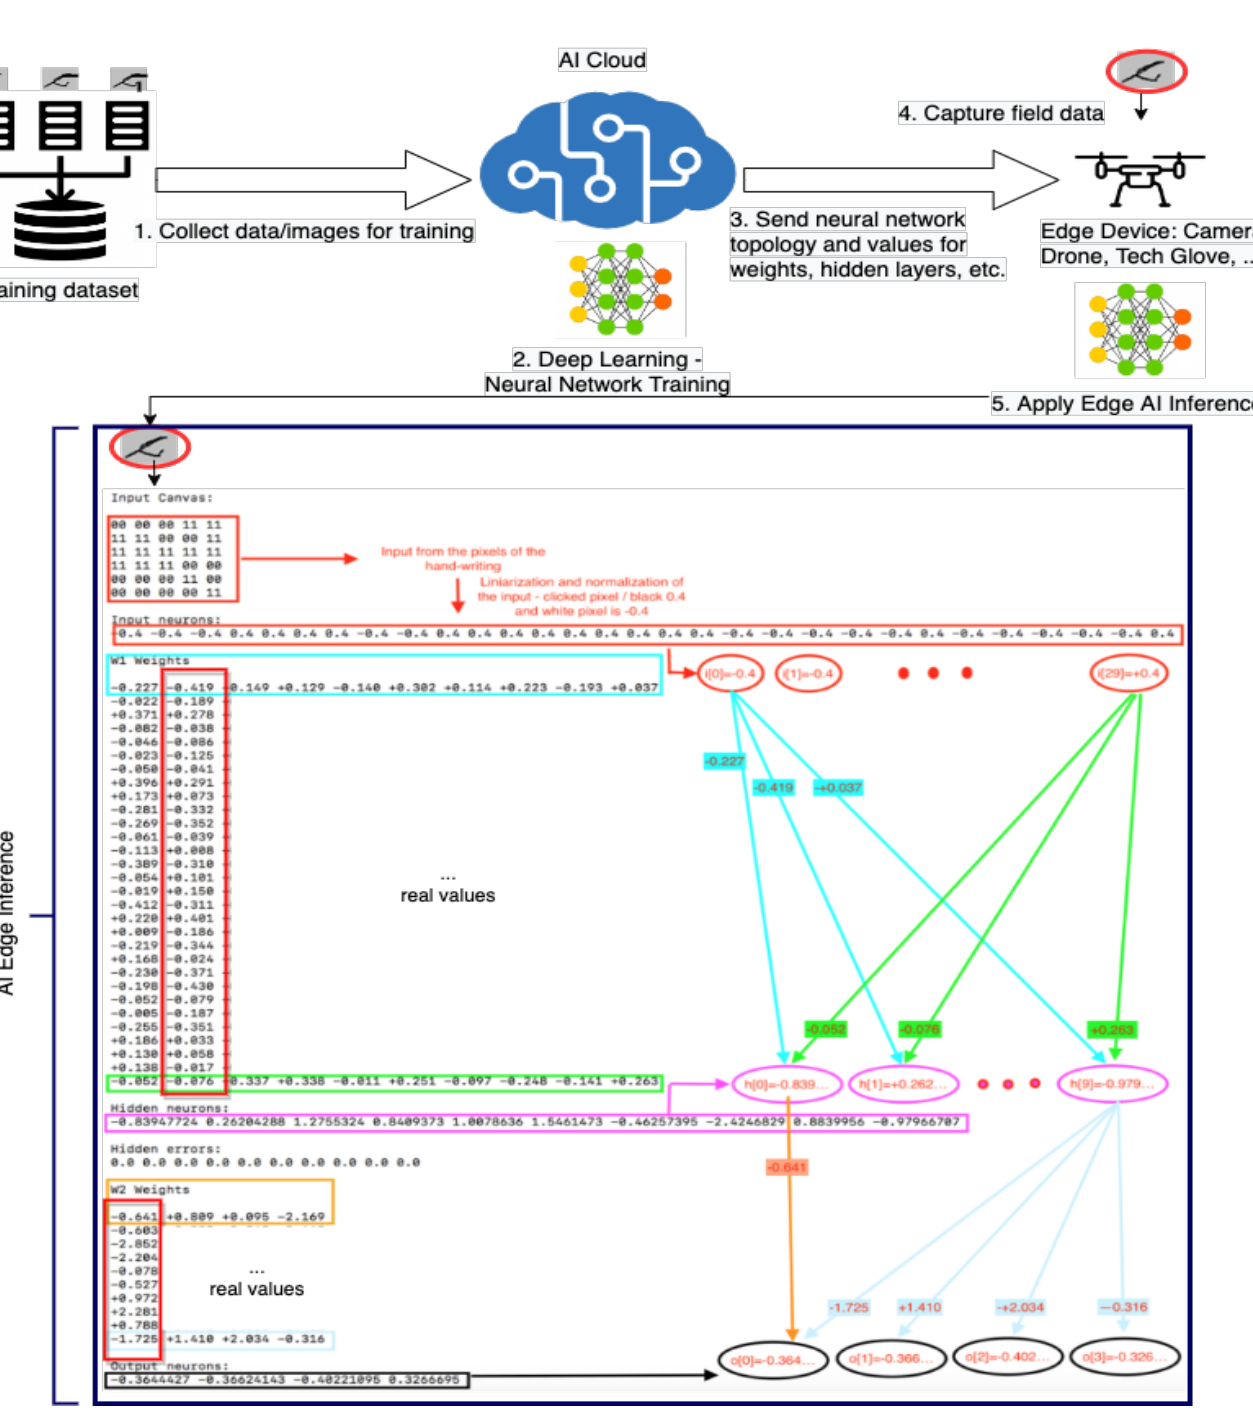
Figure 2. Neural network values for hidden layer and for weight matrices after the training process.